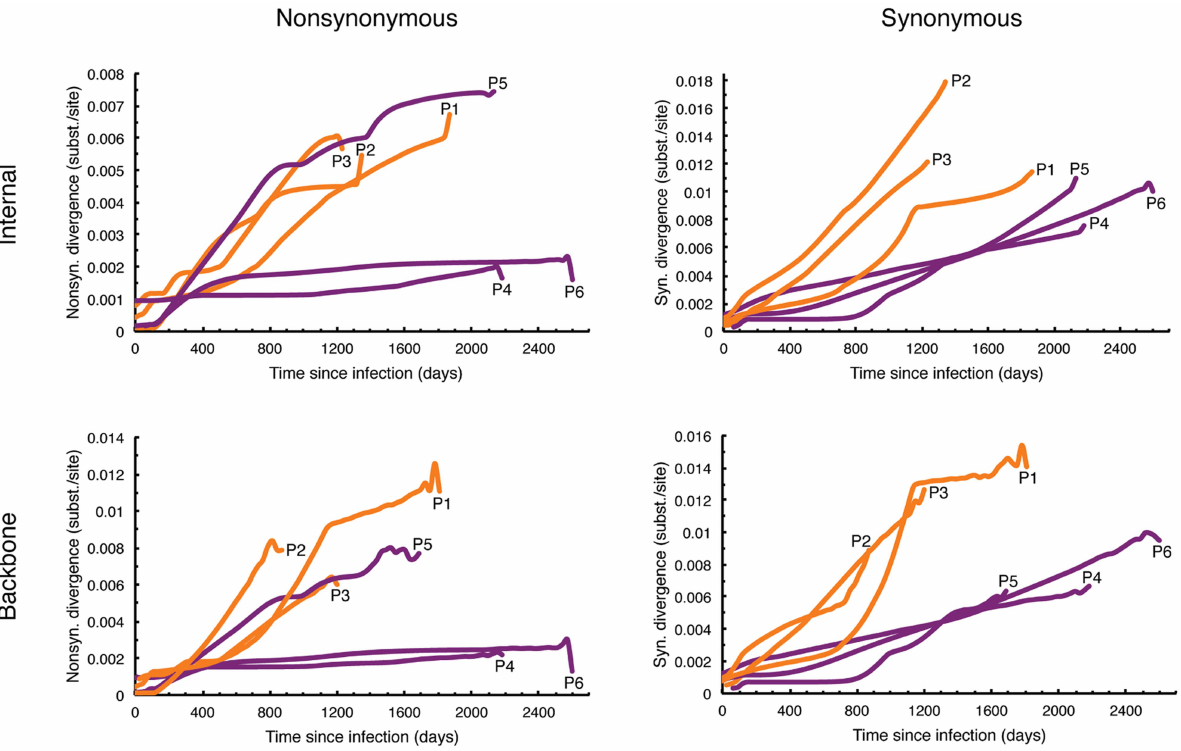
Figure 4. HIV-1 mean nonsynonymous and synonymous divergence for internal branches over time in HLA-B*5701 subjects. Subject- specific estimates were based on 200 randomly sampled trees from the posterior distribution obtained with a Bayesian coalescent